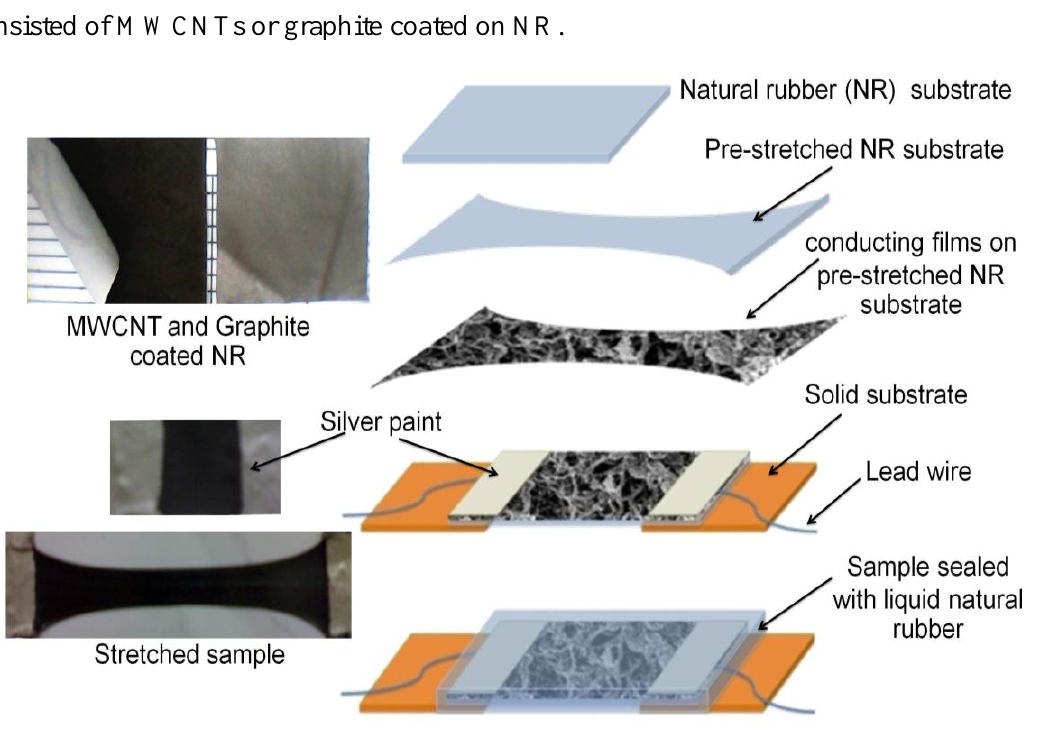
Figure 2. ( a , b ) SEM images of unstrained (0%) and strained (400%) MWCNT-coated NR samples; ( c , d ) SEM images of unstrained (0%) and strained (400%) graphite-coated NR